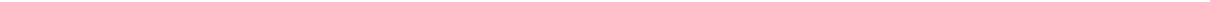
(Table 1) in the fi rst-line setting. In the second-line meta-analysis, (Table 1). Of HR + patients with known VM status treated in